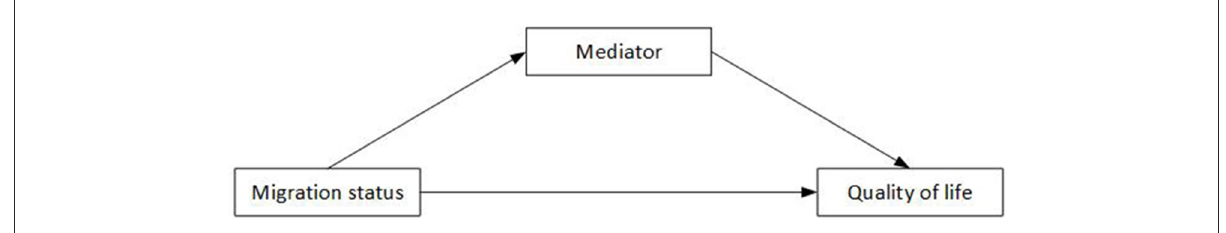
FIGURE2 Mediation model in estimating the indirect association between migration status and QoL.